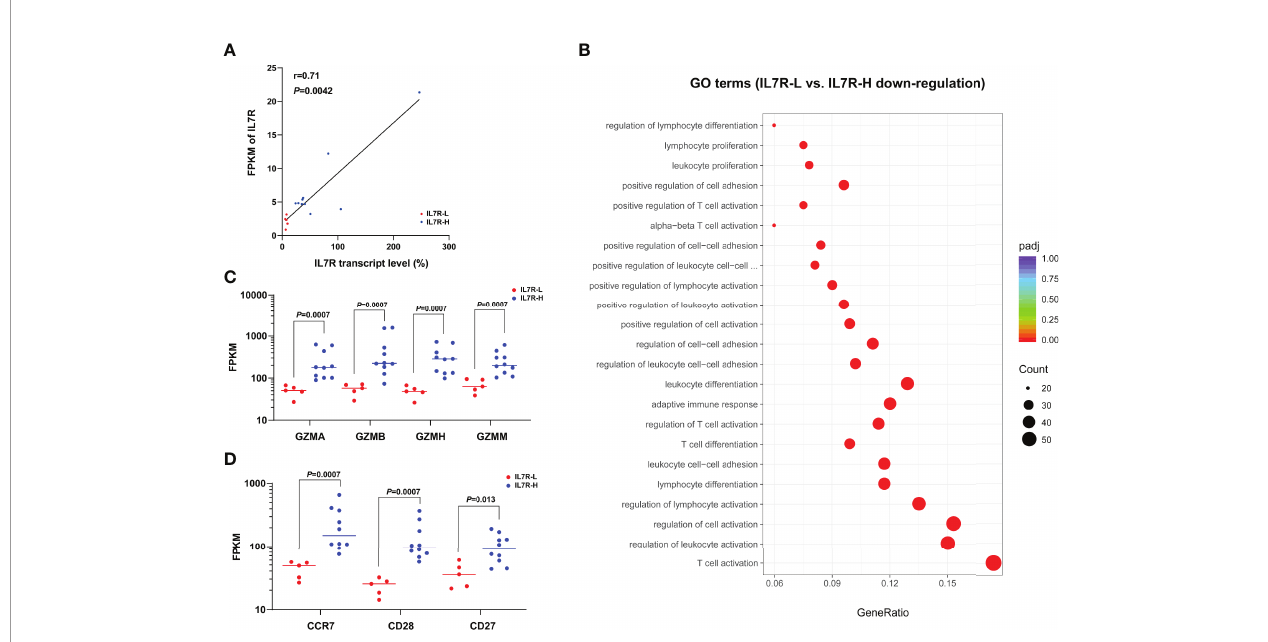
FIGURE 4 | (A) Correlation of IL7R transcript level and FPKM of IL7R (bivariate Spearman correlation test); (B) Signi fi cantly down-regulated GO terms for IL7R-L compared with IL7R-H group; (C) Comparison of FPKM of granzymes A/B/H/M between IL7R-L and IL7R-H group; (D) Comparison of FPKM of CCR7, CD28 and CD27 between IL7R-L and IL7R-H